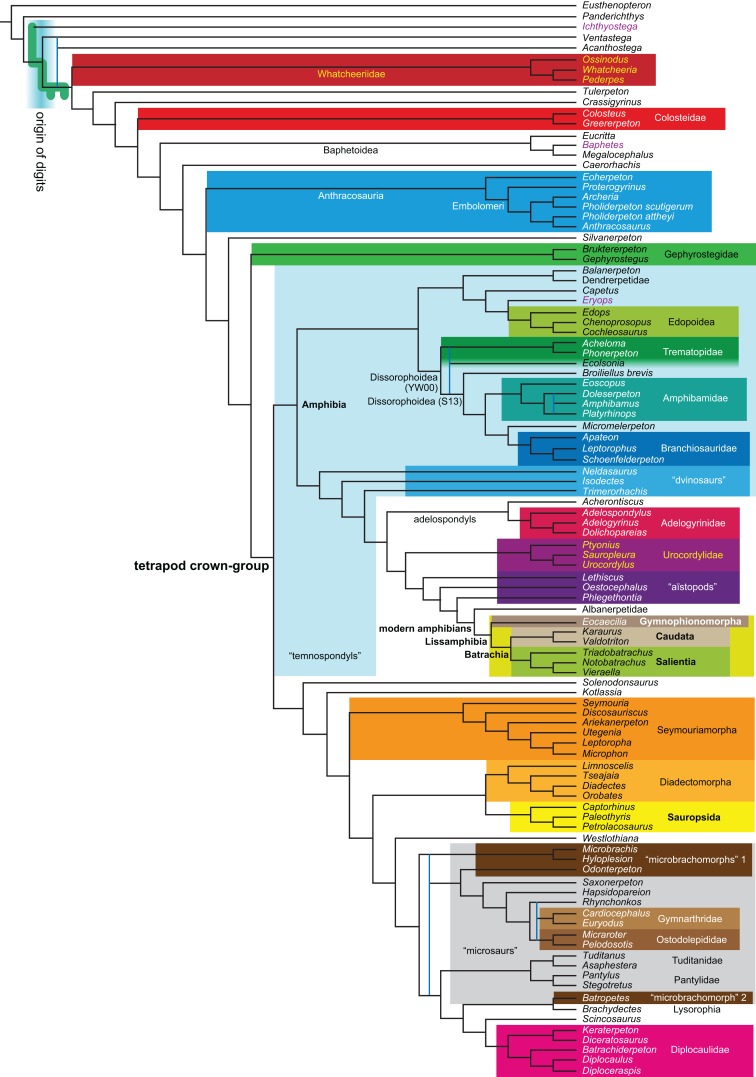
Representation of all MPTs (length: 2,191 steps) from Analysis R2, performed on our revised matrix.The taxon sample was unchanged from RC07. A constraint forced the three salientians (Triadobatrachus, Notobatrachus, Vieraella) to be closer to the dissorophoid temnospondyl Doleserpeton than to the lysorophian “lepospondyl” Brachydectes; this allowed both the TH and the PH. Teal underlay as in Figs. 10 and 11.